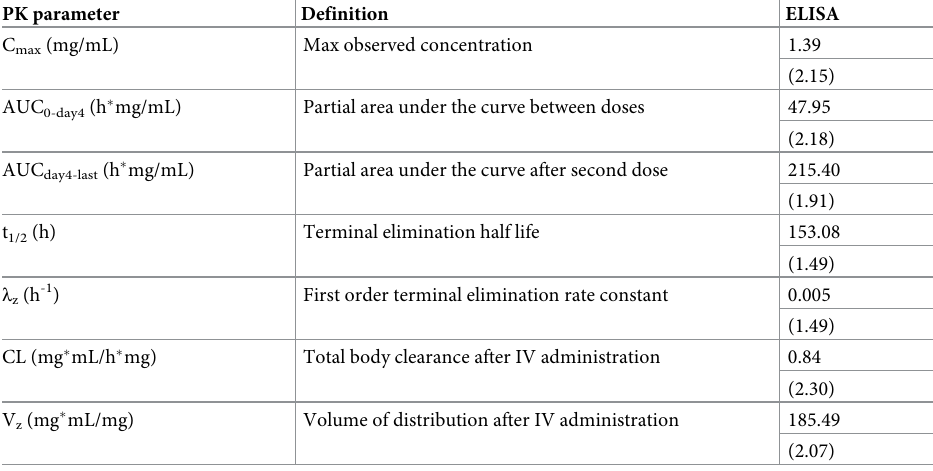
Table 1. Pharmacokinetics of ZIKV-IG based on whole virion binding ELISA presented as the geometric mean and geometric standard deviation in